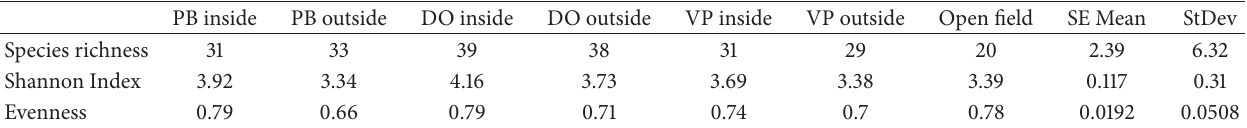
Table 2: Species richness, diversity, and evenness from inside and outside crown zones and the open field, with the estimates of their standard deviation (StDev) and Standard Error of the Mean (SE Mean). PB: P. biglobosa ; DO: D. oliveri ; VP: V. paradoxa .